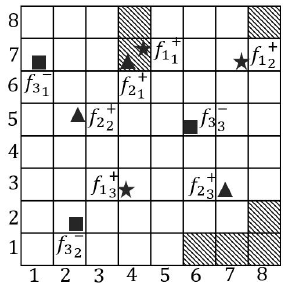
Figure 3. An Area Skyline